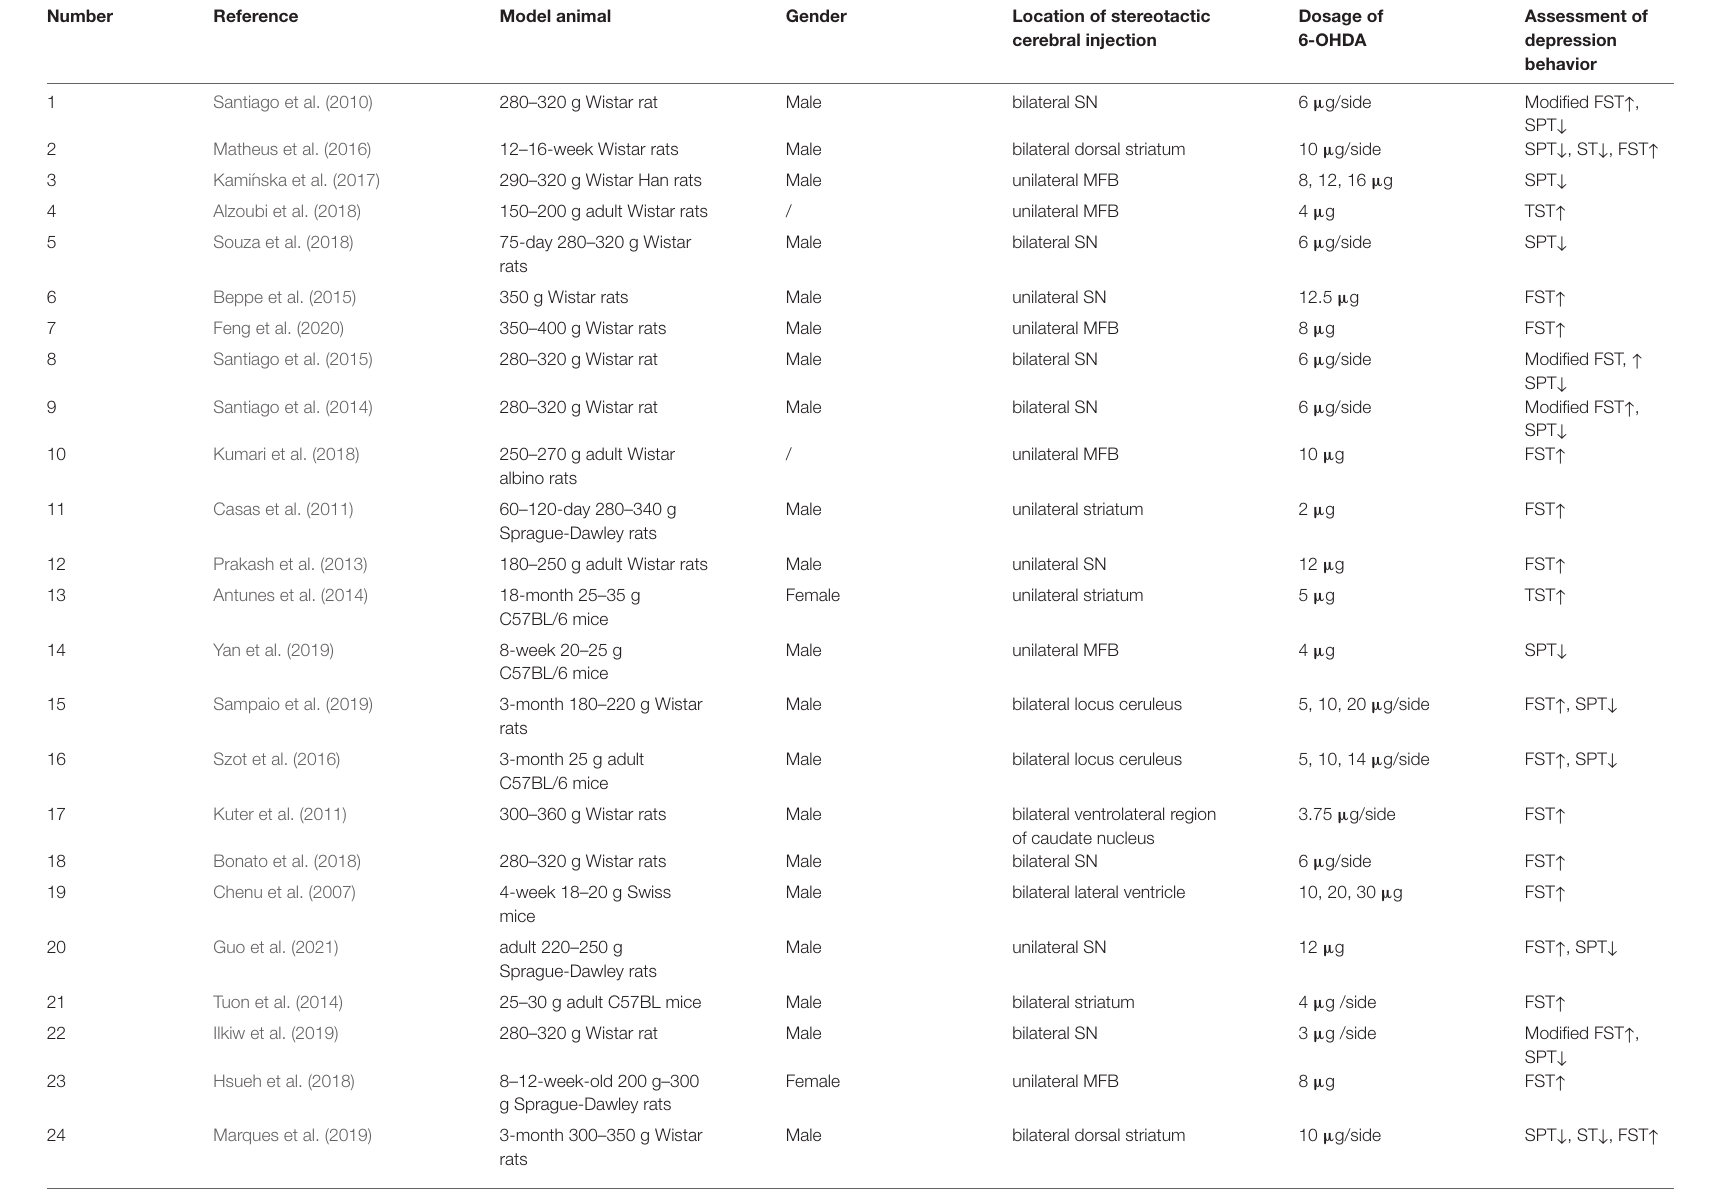
TABLE 2 | Summary of animal models of PD-related depression induced by